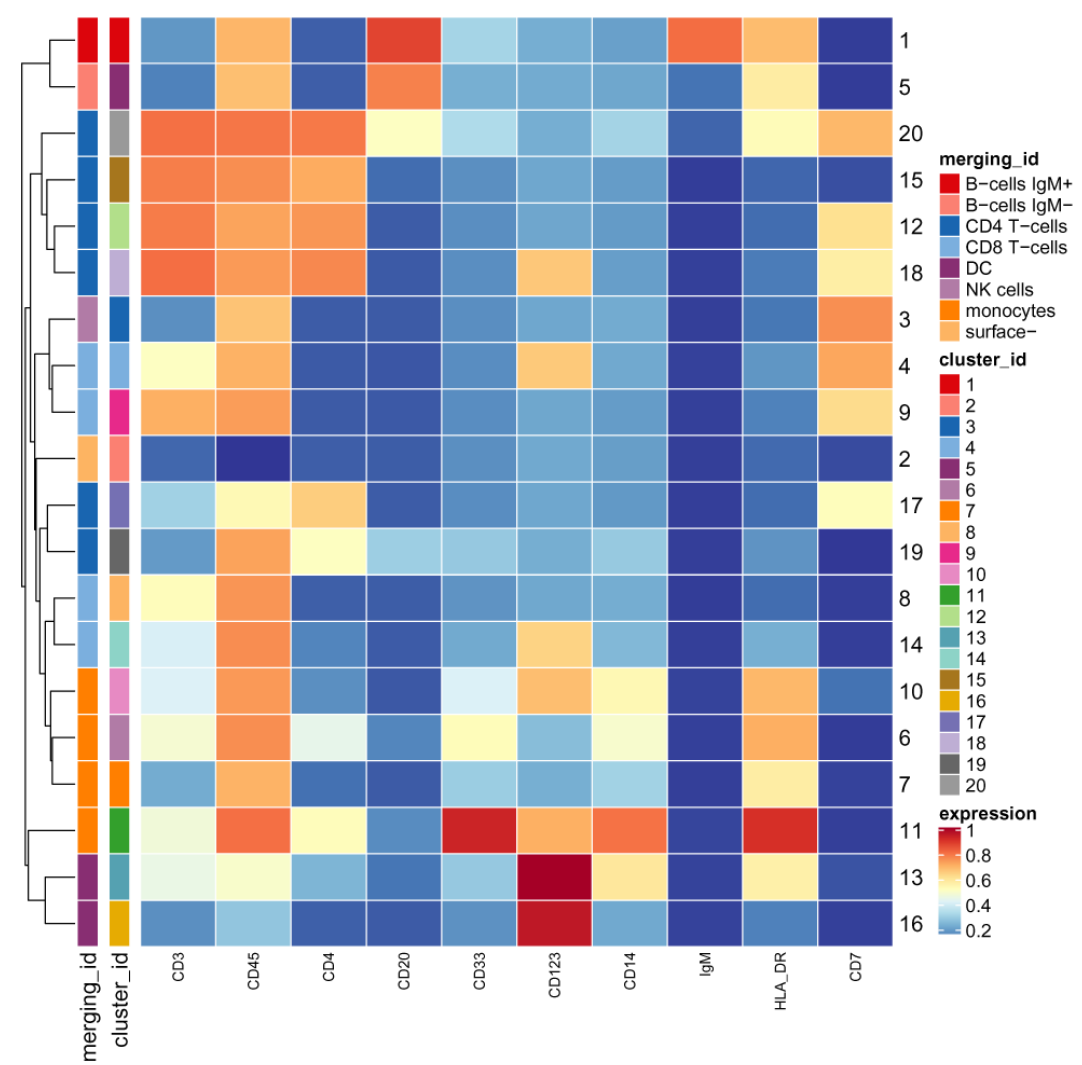
Figure 16. Heatmap as in Figure 6, where the additional color bar on the left indicates how the 20 metaclusters, obtained with FlowSOM, are merged into the 8 PBMC populations.